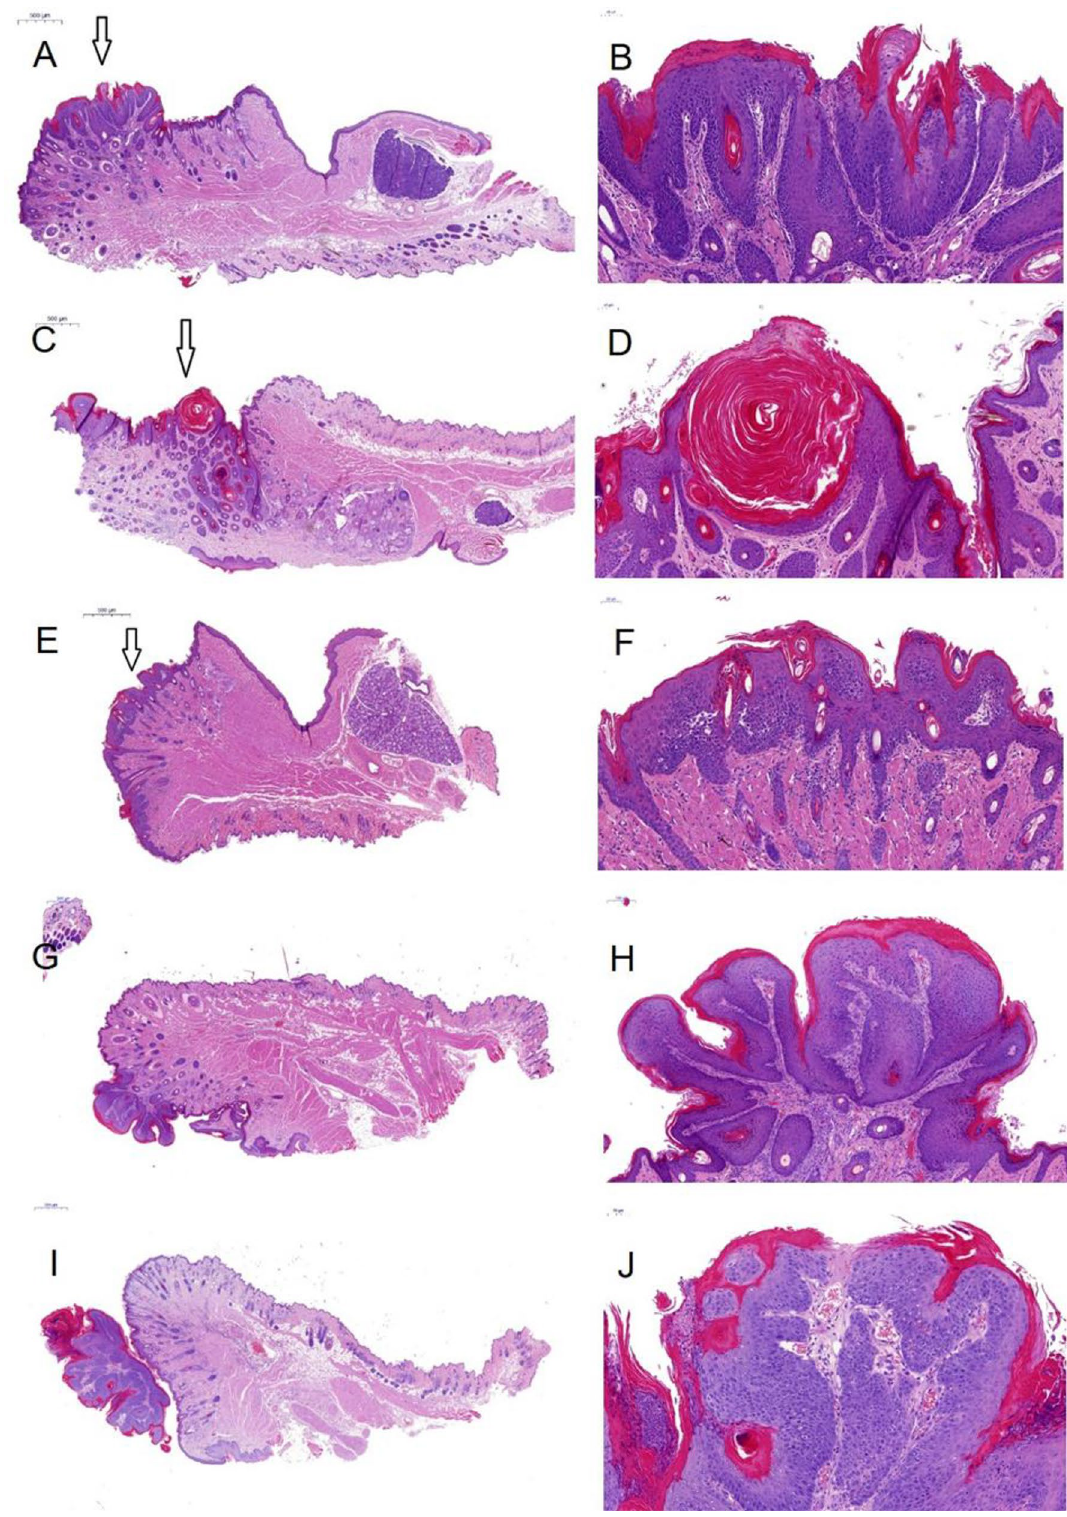
Figure 3. Representative histological analysis of non-invasive lesions of the mucosa. Haematoxylin–eosin staining of the oral mucosa of mice with different changes, summarized as non-invasive lesions [( A , B ): hyperkeratosis with mild dysplastic changes; ( C , D ): hyperplasia and hyperkeratosis with mild to moderate dysplastic changes; ( E , F ): mild to moderate dysplastic changes; ( G , H ): papilloma without dysplasia; ( I , J ): papilloma with moderate dysplastic changes; ( A , B ): ultraviolet (UV) 8 s + dibenzo(a)pyrene (DBP) high dose; ( C , D ): UV 48 s + DBP high dose; ( E , F ): untreated + DBP high dose; ( G , H ): UV 8 s + DBP low dose; ( I , J ): kINPen 10 s + DBP low